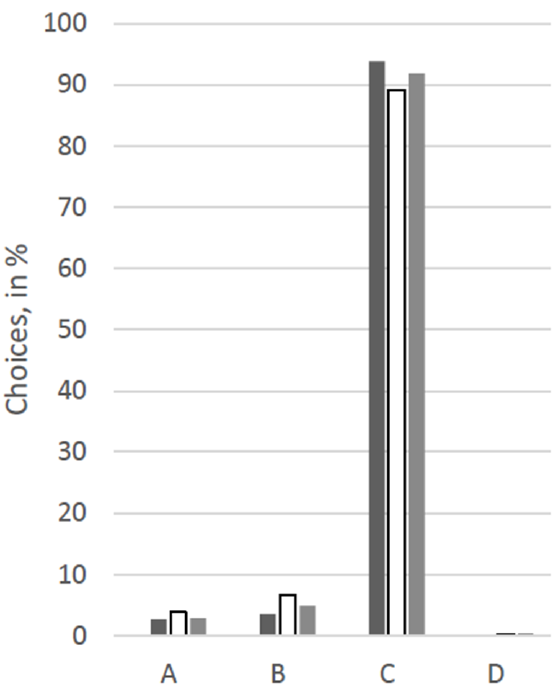
Figure 3. Answers for the scenario “11-year-old human” in %. Legend: black: human medicine group; white: control group; grey: veterinary medicine group; A: Euthanasia tablet, B: Sedation tablet, C: Potentially curative tablet, D: No treatment